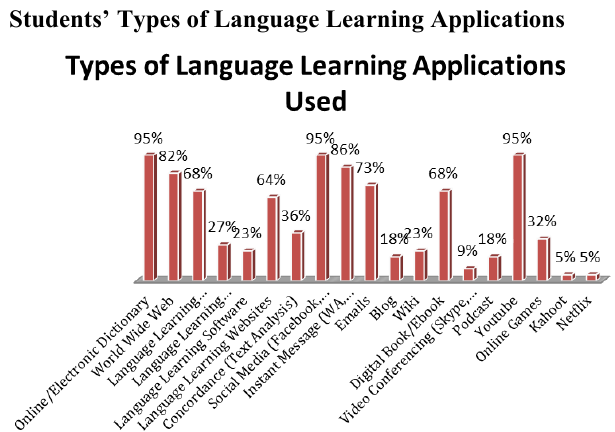
FIGURE 2 | Learning Applications Used by Students in Language Learning